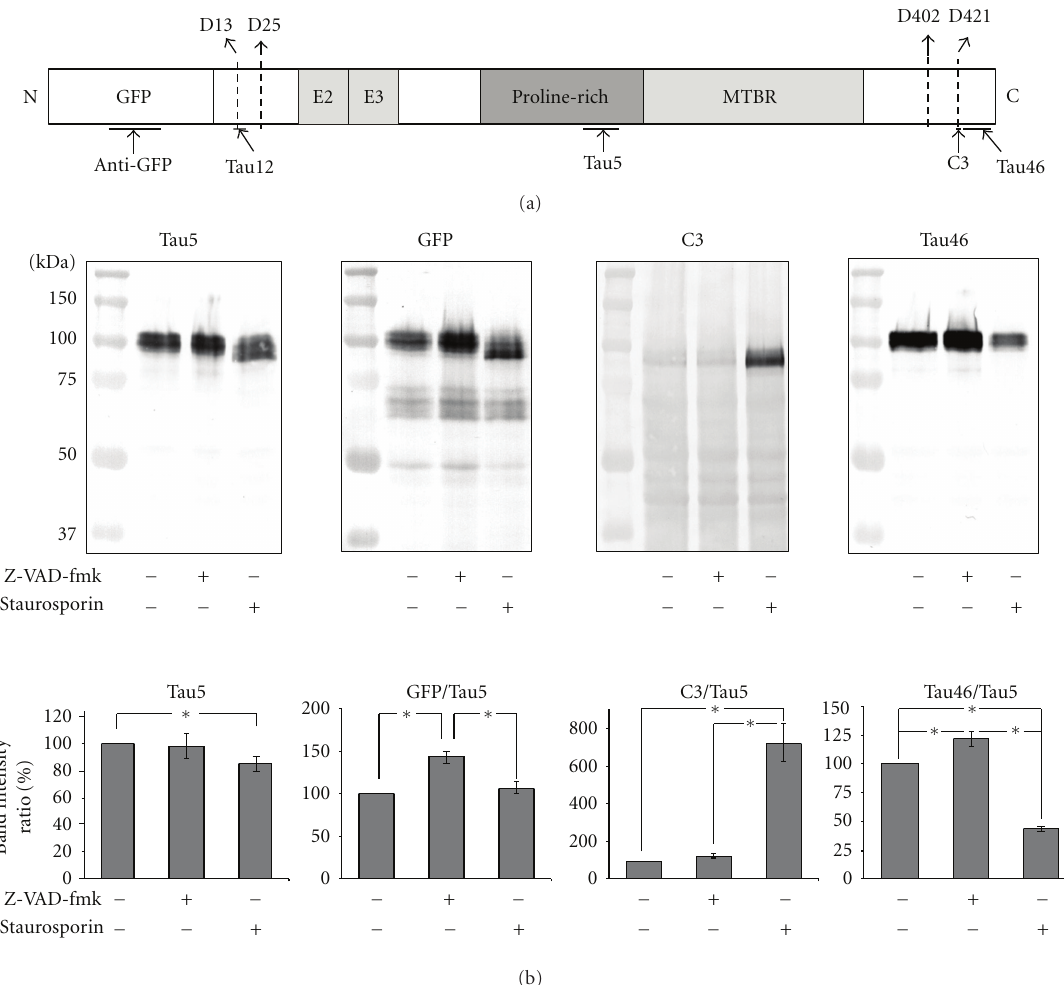
Figure 2: Tau truncation by caspases. (a) depicts GFP-tagged 3PO tau. The caspase cleavage sites reported in AD brains and the epitopes recognized by the antibodies used for the truncation detection in this study are noted. GFP tagged 3PO tau is depicted. Caspase-3 has been reported to cleave tau at D25 and D241. Caspase-6 has been reported to cleave tau at D13, D402, or D421. (b) presents representative immunoblots of lysates from cell expressing GFP-3PO with and without treatment with staurosporine or Z-VAD-fmk as indicated. Migration of molecular weight standards is indicated on the left of each blot. The accompanying graphs presents the mean intensities ( ± SEM) derived from 4 independent immunoblots. The relative intensities of the uppermost bands from anti-GFP, C3, and Tau46 were normalized to those of Tau5; lower-molecular weight breakdown products were not considered in these densitometric analyses. An asterisk indicates statistical significance ( P < 0 . 05, Student’s t